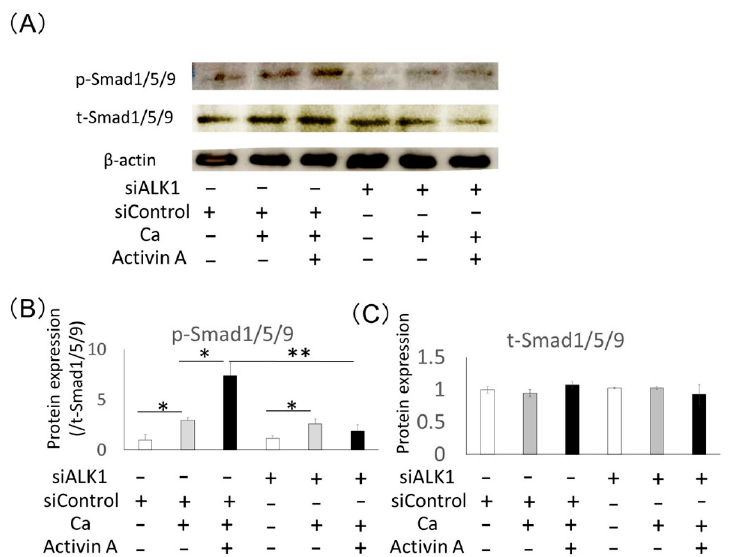
Figure 6. Treatment with siALK1 inhibited activin A-induced phosphorylation of Smad1/5/9 in Saos2 cells. ( A ) Protein expression of phospho-Smad1/5/9 (p-Smad1/5/9) and total-Smad1/5/9 (t-Smad1/5/9) was analyzed using Western blotting in Saos2 cells cultured with 0.5 mM CaCl 2 (Ca) with or without 100 ng/mL activin A. β -actin was used as an internal standard for the control. Expression levels of p-Smad1/5/9 were normalized against t-Smad1/5/9 expression, and the expres- sion levels of t-Smad1/5/9 were quantified. The results are shown as the fold increase of the control. Values are the means ± SD from three independent experiments. * p < 0.05, ** p < 0.01.